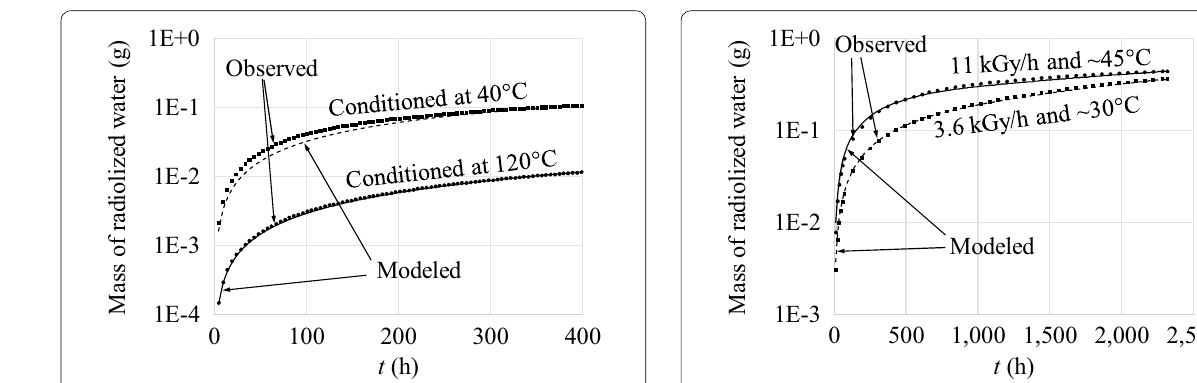
Fig. 6 Mass of radiolyzed water (estimated as 9-times the mass of evolved H 2 ) vs. time for cement paste specimens irradiated at approximately 8.3 kGy/h, as observed by Kontani et al. (2013) vs. modeled according to (16), (18), and (20).